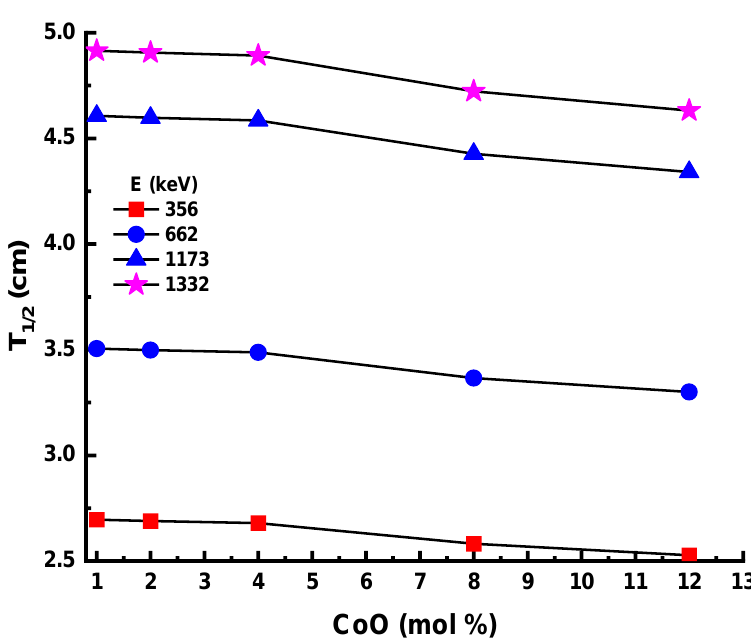
10 of 14 Figure 9. Experimental and theoretical mass attenuation coefficient (µ m ) against glass composition. Figure 10 displays the behavior of the half-value layer values (T 1/2 ) for the five test samples in the present study. This shows that the lowest T 1/2 values were observed at 356 keV, while the highest T 1/2 values were at 1332 keV. This could be described by the pene- tration potential of gamma rays, depending on their energy, which means that the low